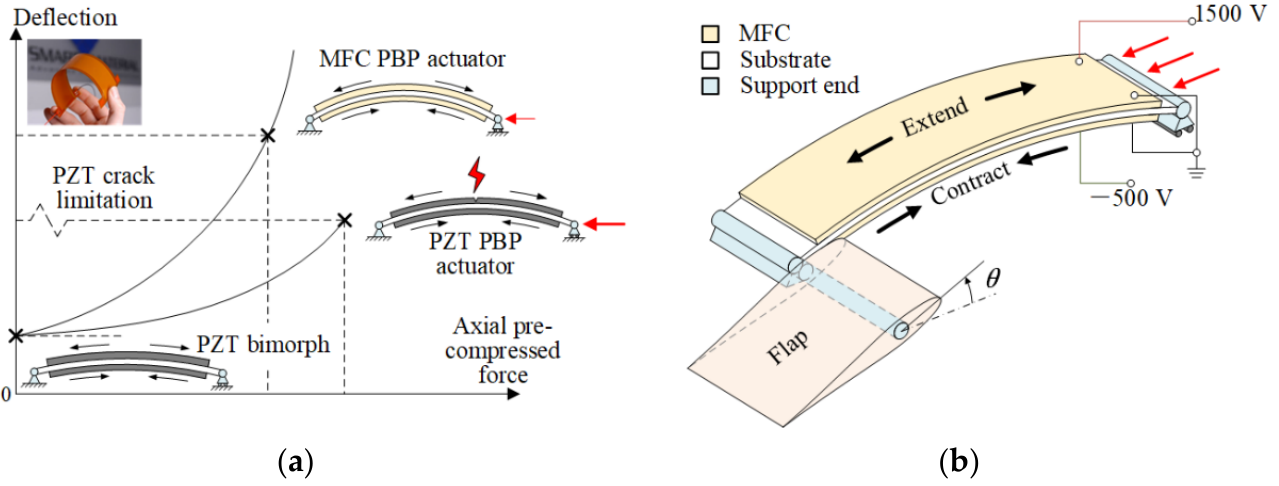
Figure 1. Operating principle of MFC-PBP actuator: ( a ) comparison of actuation performances of MFC-PBP and PZT-PBP; ( b ) micro flap derived by MFC-PBP [5].